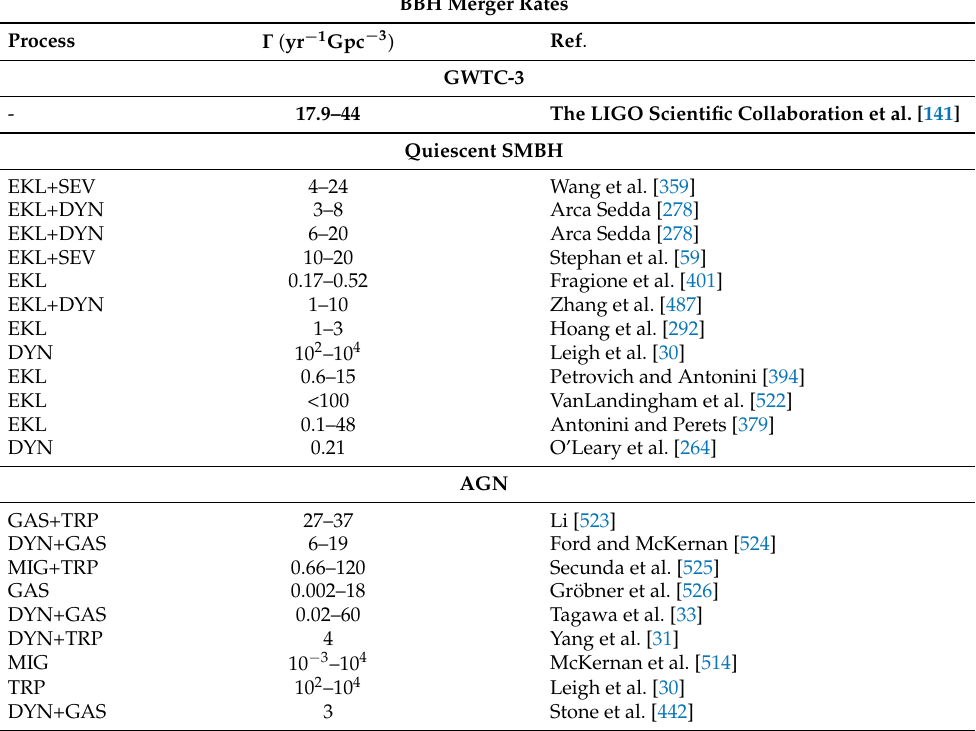
Table 1. BBH merger rate density for quiescent SMBHs and AGNs. Column 1: type of physical processes included—Kozai–Lidov (EKL), dynamical scatterings (single–single or binary–single, DYN), binary stellar evolution (SEV), gaseous capture via migration and/or dynamical friction (GAS), migration (MIG), and pairing in migration traps (TRP). Column 2: merger rate density. Column 3: reference. When a volumetric rate density was not provided in the referenced paper, we adopted, when required, a local galaxy number density of ρ glx = 0.0116 Mpc − 3 [512,513] and an average number of BBH binaries in an MW-like nucleus of N BBH = 200 [278,292].